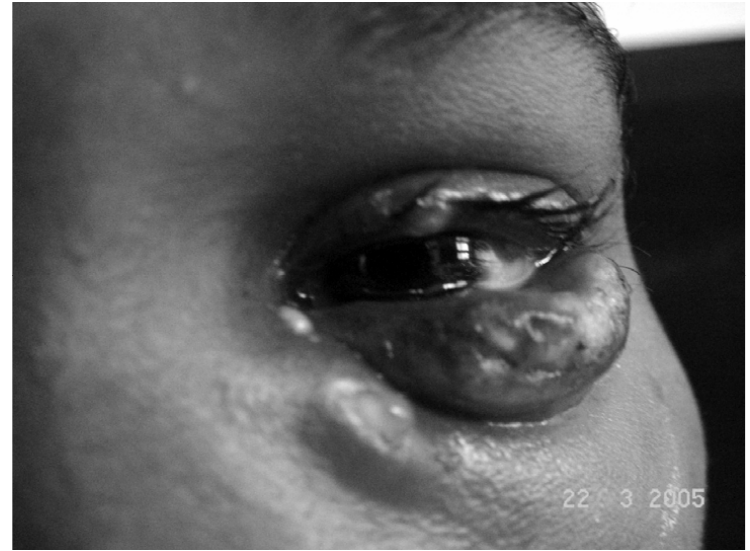
Fig. 4 – Ulcerated granulomatous lesion draining purulent discharge affecting the ocular conjunctiva and surrounding skin in an adolescent